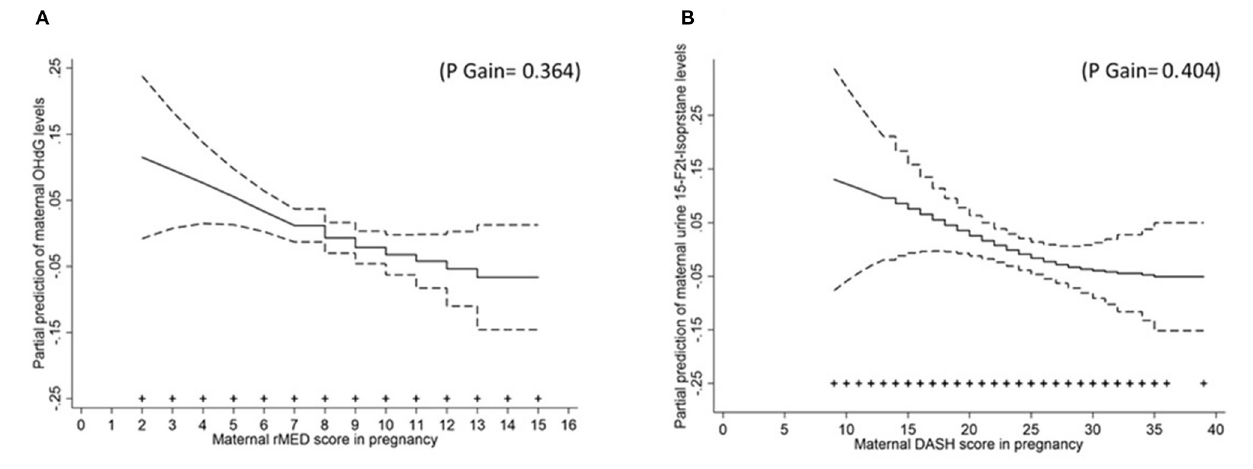
FIGURE 1 | The relation (and 95% confidence levels [ CI s]) of maternal dietary scores in pregnancy with the concentrations of selected maternal biomarkers of oxidative stress. General additive models adjusted for maternal social class, maternal smoking during pregnancy, and total intake of calories for (A) the